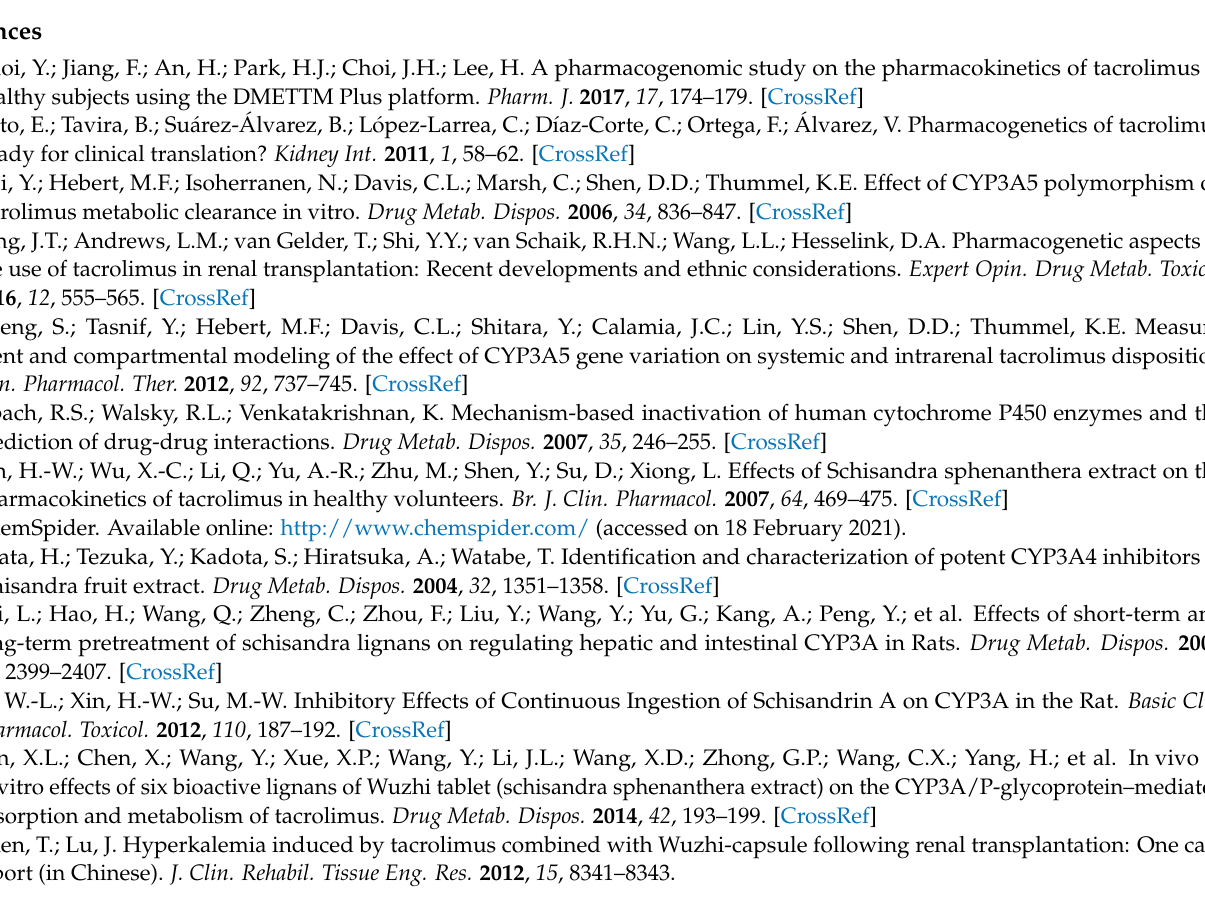
Table S3: Parameters used for PBPK modeling of schisantherin A and schisandrin A; Table S4: Parameters used for PBPK modeling of tacrolimus; Table S5: C max and AUC of tacrolimus under different K p values; Table S6: Demographic information used for PBPK modeling of